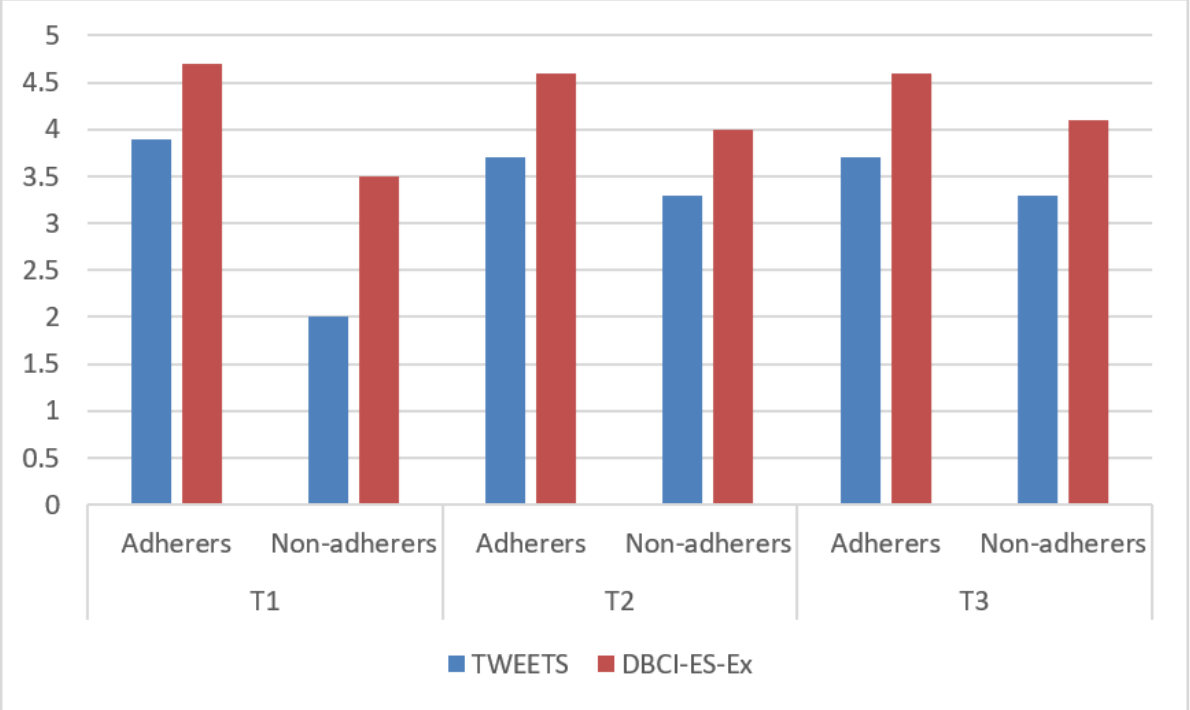
Figure 1. Engagement scores of adherers and nonadherers at the different time points. DBCI-ES-Ex: the experiential subscale of the Digital Behavior Change Intervention Engagement Scale; T: time point; TWEETS: TWente Engagement with Ehealth Technologies